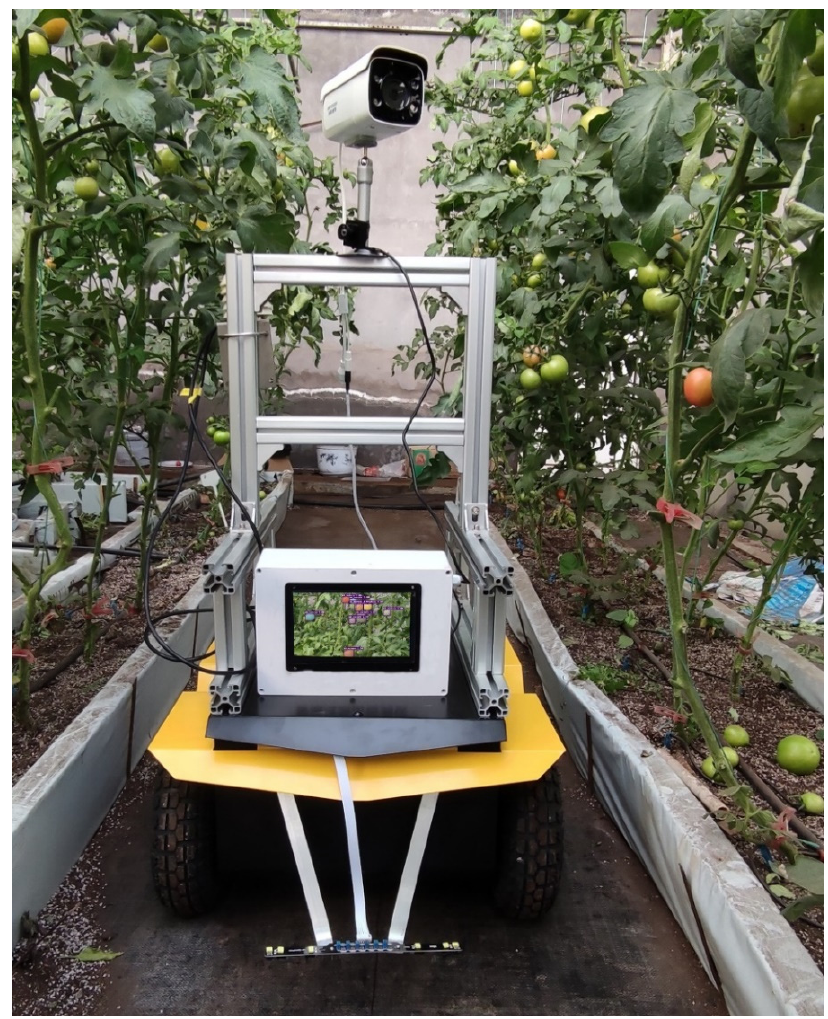
Figure 7. Model performance evaluation experiment in greenhouse field environment.